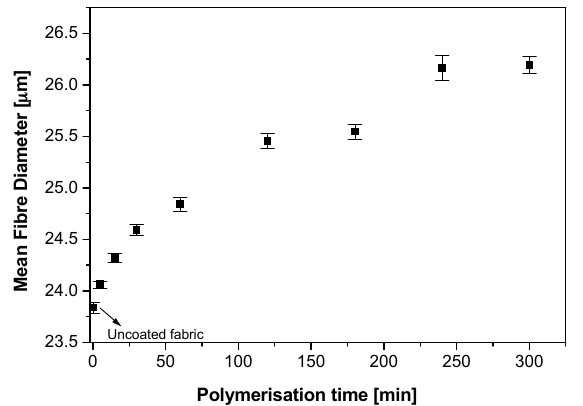
Figure 1. The variation of the diameter of Nylon-Lycra fibre with polymerisation time. Dopant concentration 0.018 mol/L p TSA.